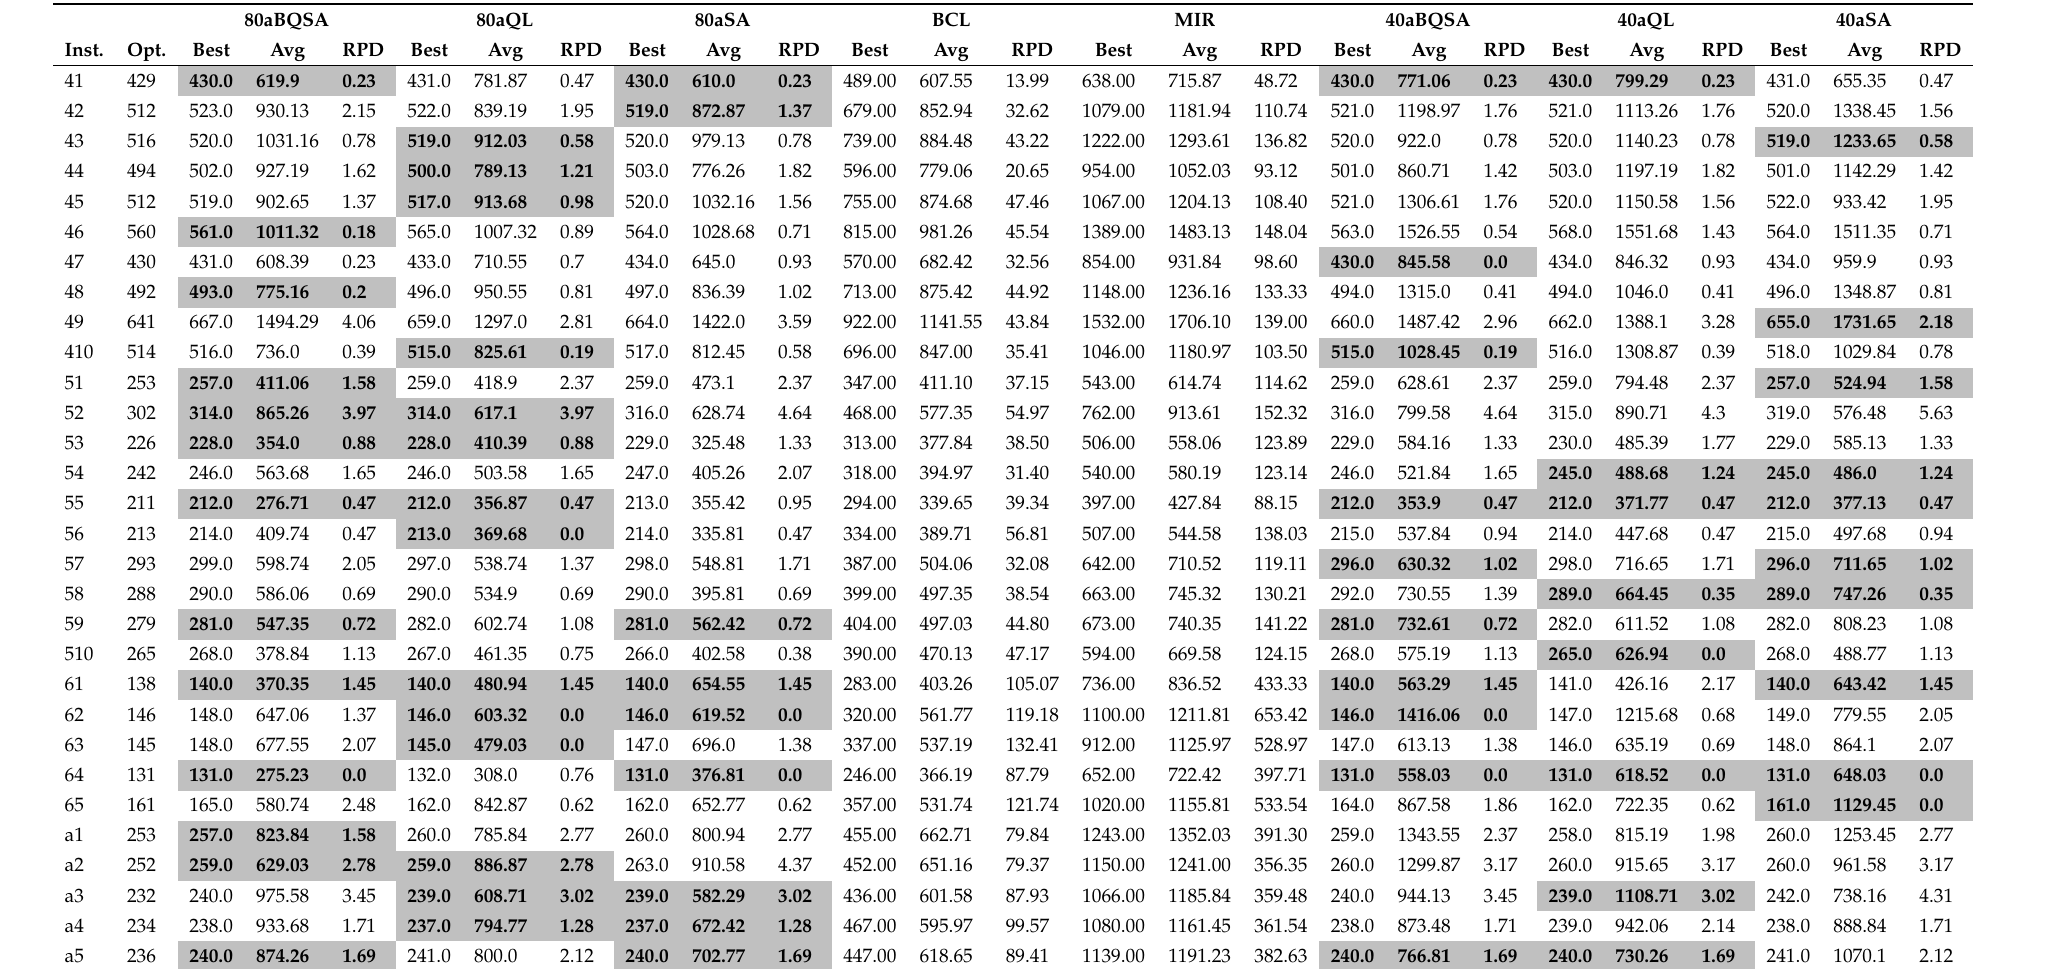
Table 5. Comparison of the metaheuristics’